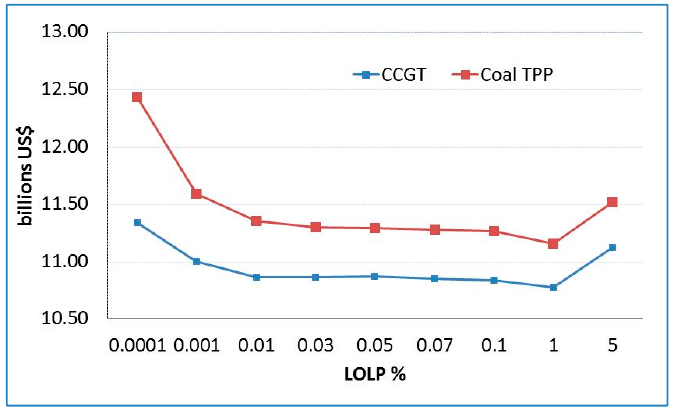
Figure 5. LOLP optimization for VOLL $2 USD/kWh with CCGT and coal fired TPP.